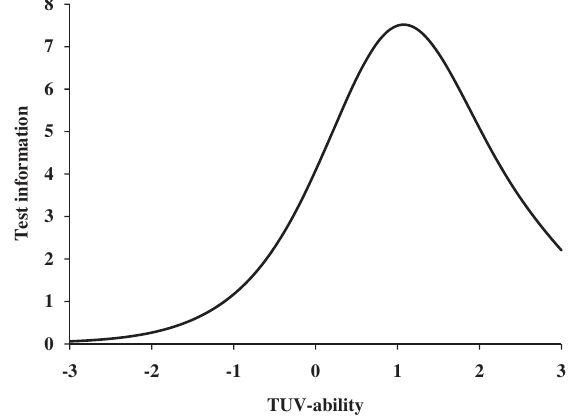
FIG. 4. Test information curve of the 20-item TUV across ability levels of the Thai students